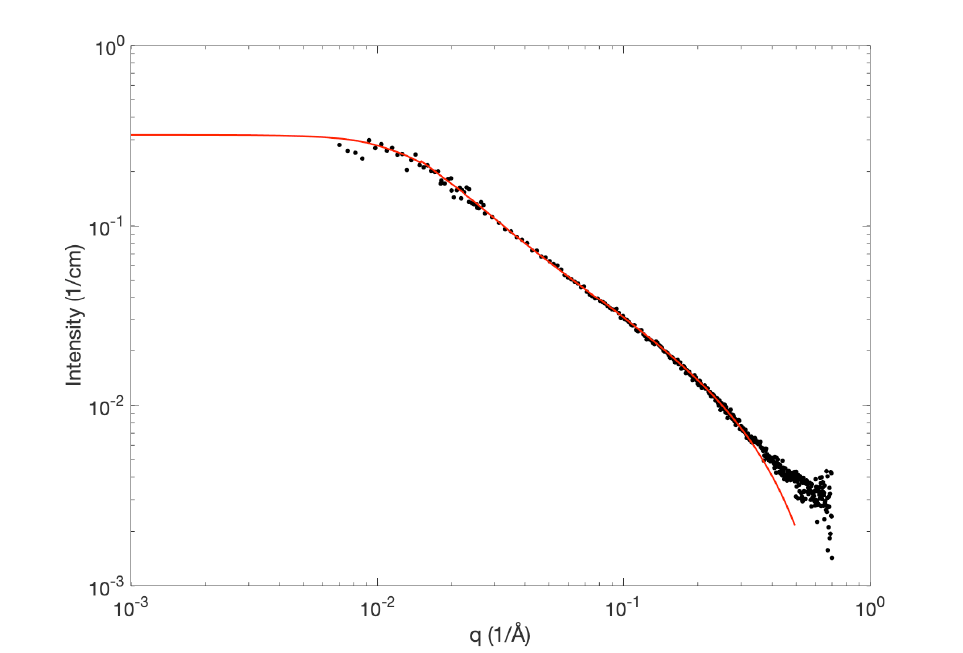
Figure 3. Experimental data for 2 wt % MCC in 8 wt % NaOH (black dots) together with the theoretical scattering profile of semi-flexible cylinders (red curve). The model parameters used for the semi-flexible cylinder scattering profile were a radius of 4.1 Å, a persistence length of 100 Å and a total contour length of 600